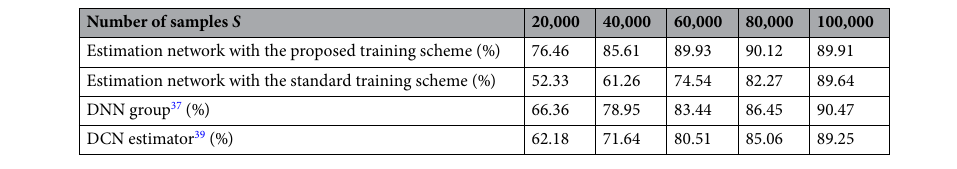
Table 1. Micro-F1 accuracy versus different number of